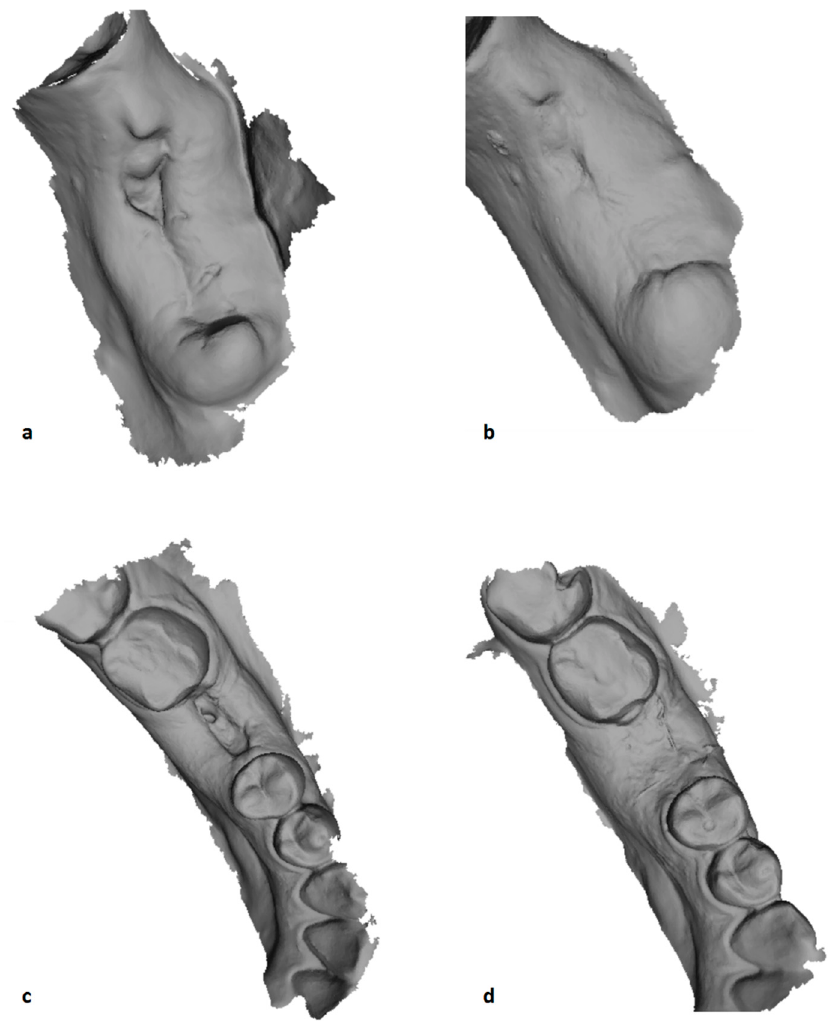
Figure 2. This is a figure showing two screenshot of the 3-D printing at the moment of volumetric calculation after 7 (T 1 : ( a , c )) and 14 days (T 2 : ( b , d )) from the first molar extraction in the test and control groups. ( a ) Post-extractive site at T 1 in control group; ( b ) post-extractive site at T 2 in control group. ( c ) Post-extractive site at T 1 in test group; ( d ) post-extractive site at T 2 in test group. Table 2. For each group, volume (baseline 100%), VAS score (0–10), and number of painkillers.